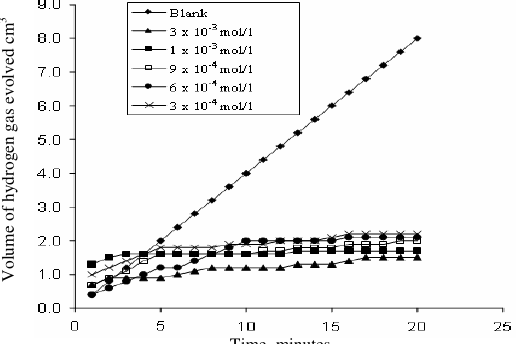
Figure 2. Variation of volume of hydrogen gas evolved with time during the inhibition of